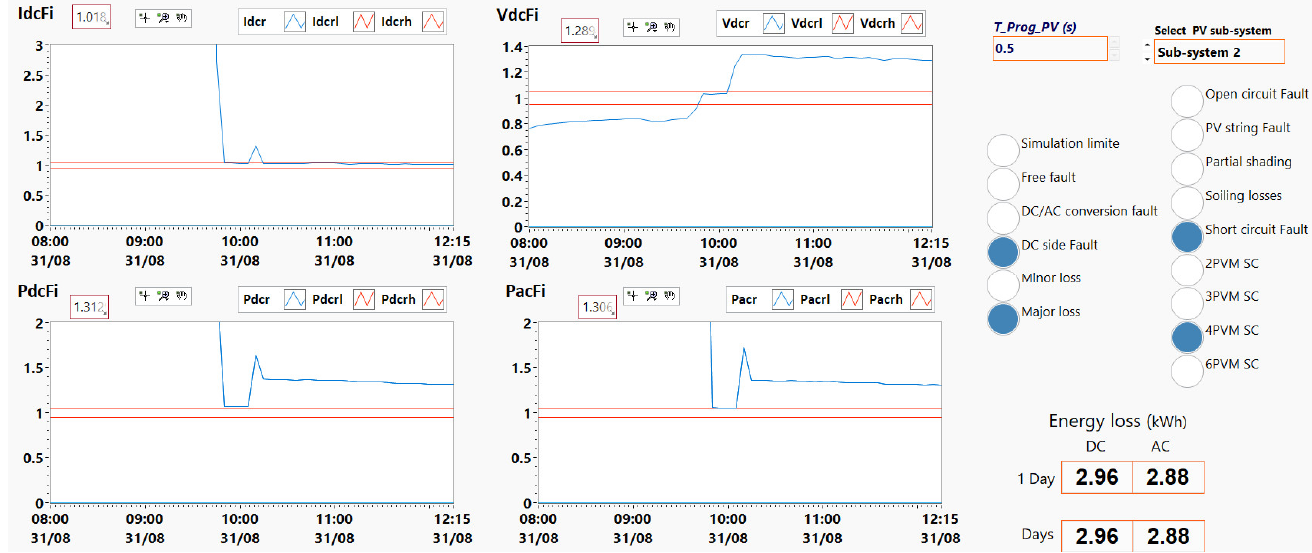
Figure 33. Identification of the four short-circuited PV modules.